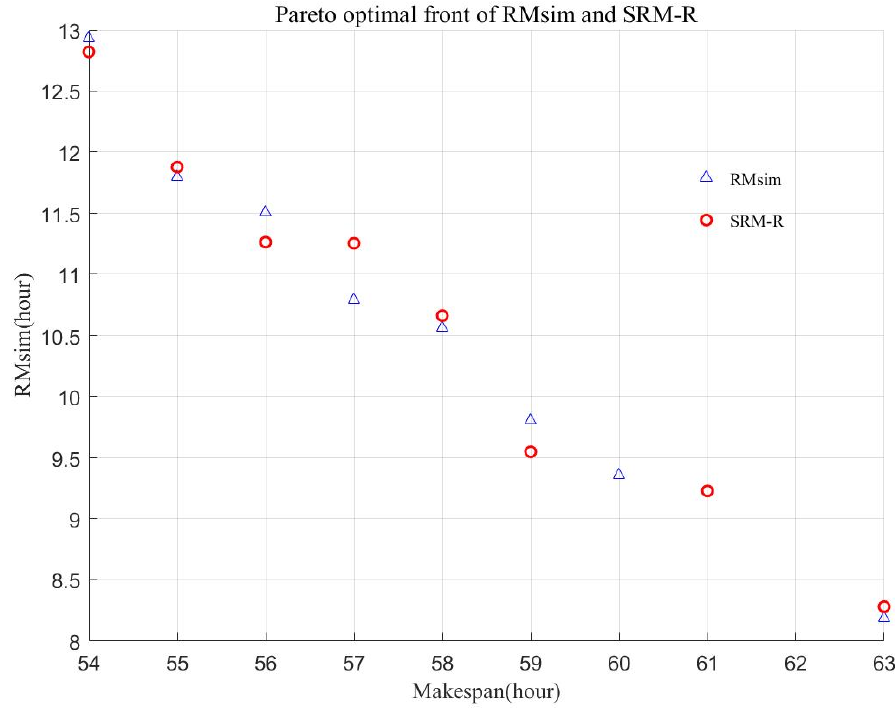
The average computation time of SRM-R is 103.57 s. The average computation time of RMsim is 563.55 s. The decreasing percentage of the computation time is up to 81.62%. To further show the robust scheduling results of the SRM-R, the Pareto front of the SRM-R is provided in Figure 4.